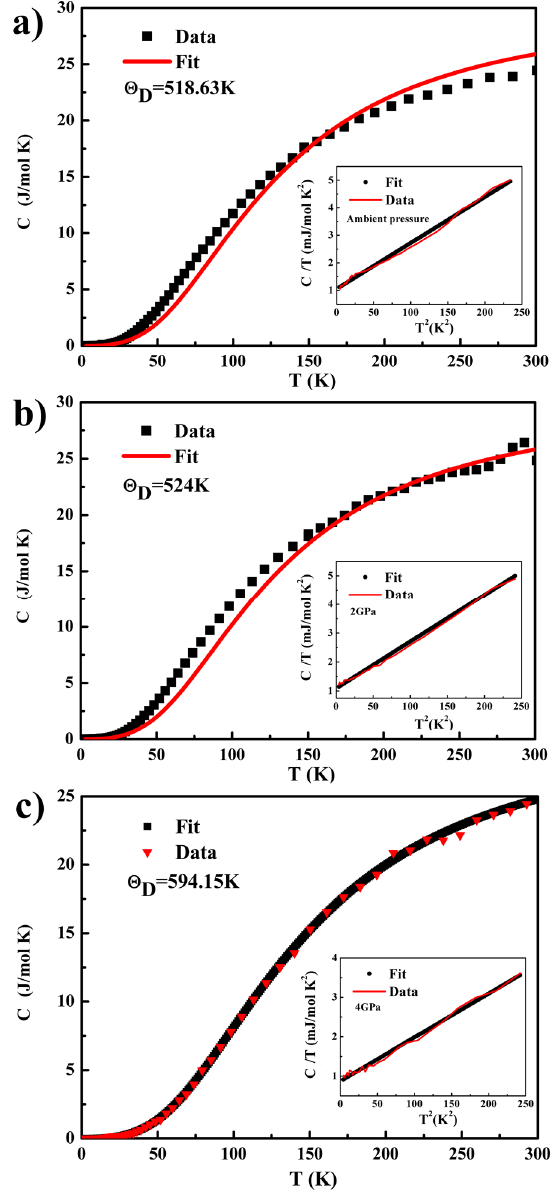
Figure 5. Heat capacity C vs. temperature T and fits of C latt (T) to the data over restricted temperature intervals for ( a ) ambient pressure; ( b ) 2 GPa; ( c ) 4 GPa. The respective insets show C(T)/T vs. T 2 for 2 K < T < 15